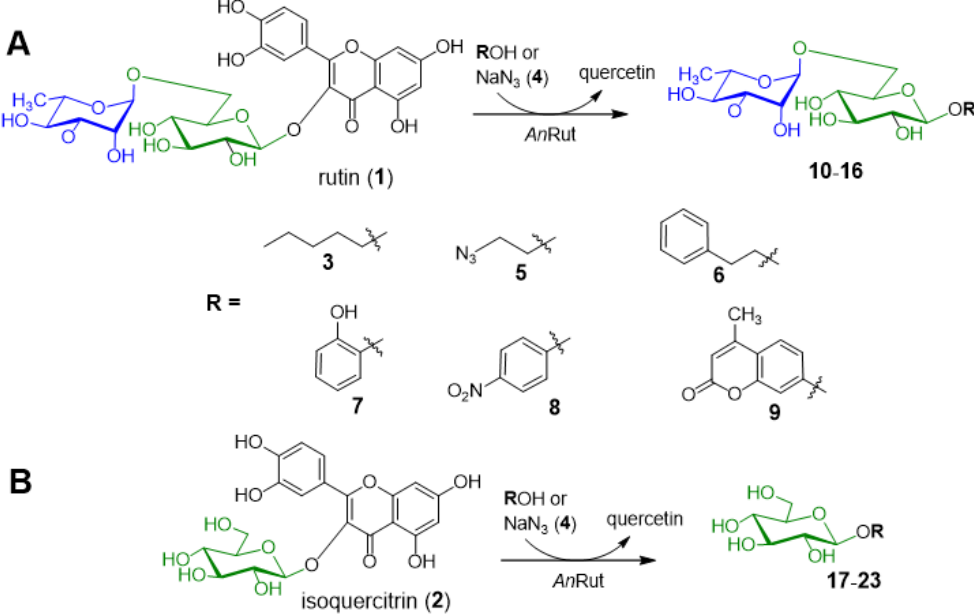
Figure 1. Transglycosylation reactions catalyzed by recombinant An Rut. Reactions with rutin ( A ) and isoquercitrin ( B ) as glycosyl donors with various acceptors.